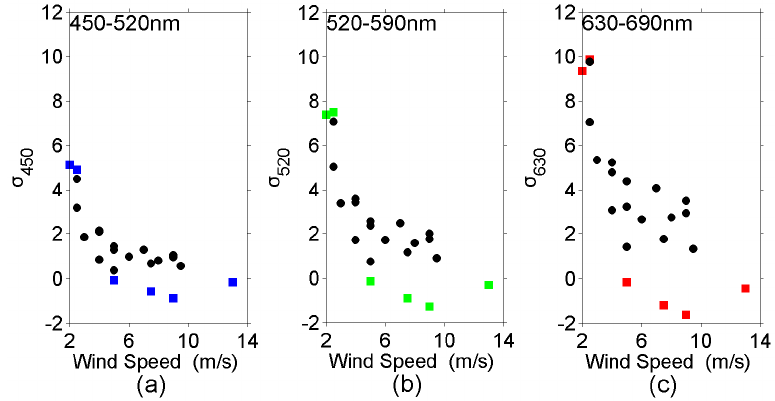
Figure 10. σ i (calibration coefficients uncertainty) with a wind speed that changed ± 2 m/s in the 22 samples: ( a ) 450–520 nm; ( b ) 520–590 nm and ( c ) 630–690 nm (colored squares represent samples with solar zenith angles between 19 and 22 ◦ ).